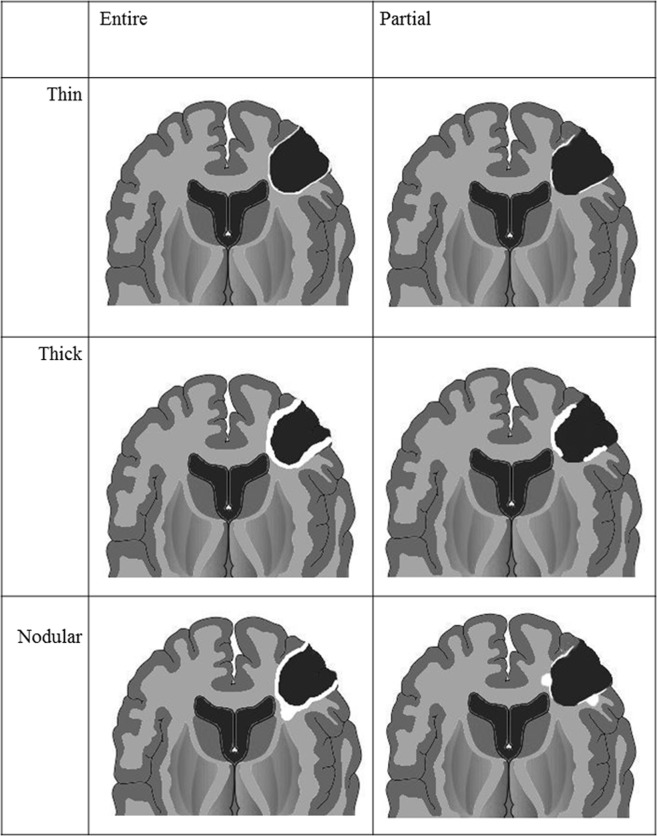
Diagram of surgical cavity wall enhancement patterns.